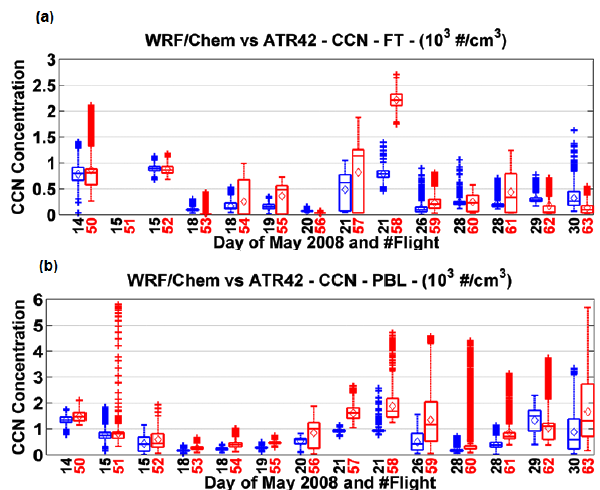
Figure 10. Same as Fig. 6 but for observed and simulated cloud con- densation nuclei (CCN) concentrations at 0.2% of supersaturation. The blue colour represents the observations, the model is displayed in red